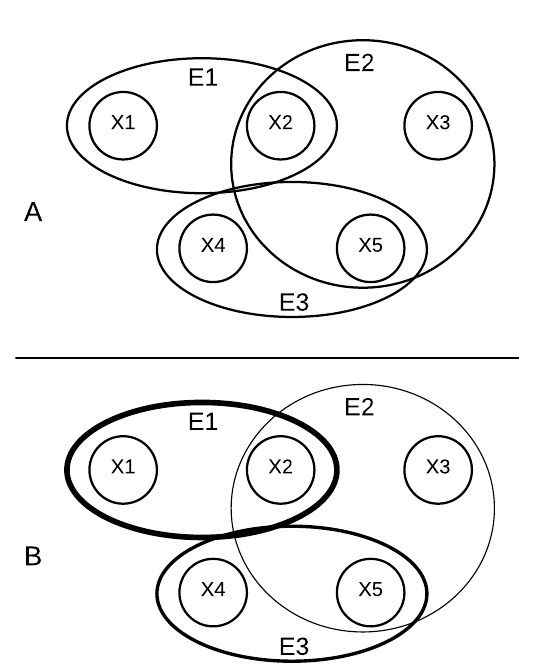
Figure 1. Hypergraph (A) and Hypernetwork (B) with five vertices and three edges set of hyperedges, and W represents the set of weights associated with each hyperedge showing its strength in the dataset. The cardinality (number of enclosed elements) of a hyperedge is referred to as the order of that hyperedge. Figure 1-B shows a hypernetwork that is synonymous to the hypergraph in figure